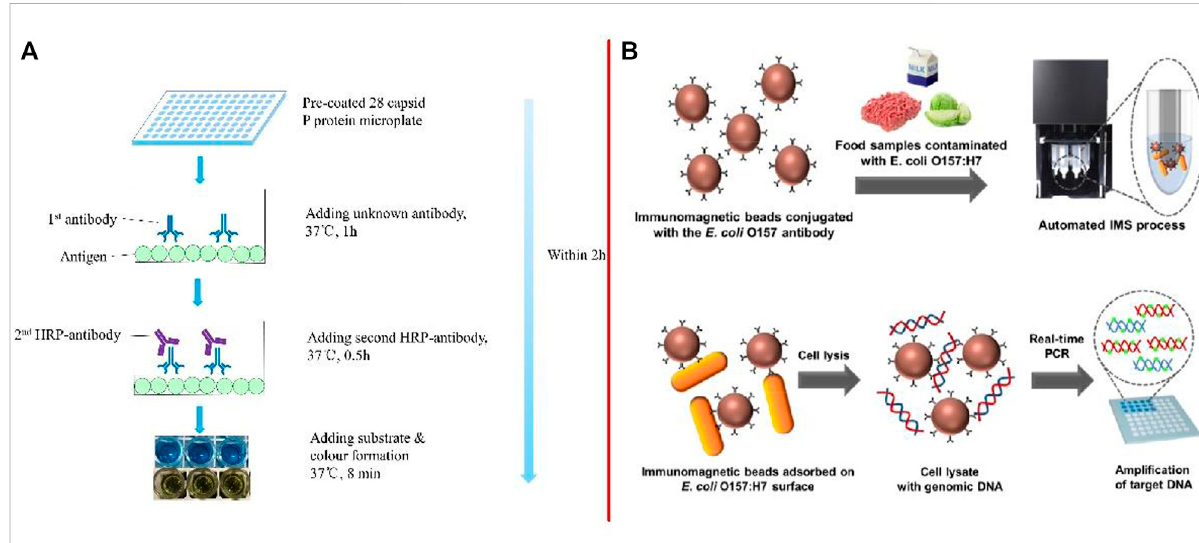
FIGURE 2 (A) Step-by-step schematic representation of ELISA (Zuo et al., 2021); (B) Schematic illustration of the detection method for E. coli O157: H7 using the automated IMS device combined with real-time PCR (Park et al.,